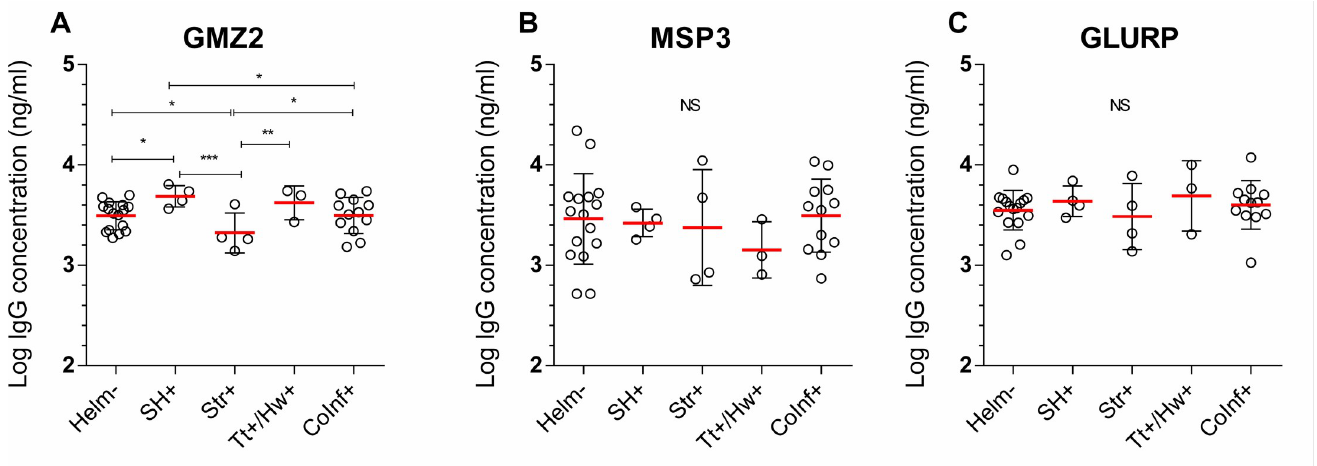
Fig 3. Post immunization antibody concentration at D84 in Helm- and Helm+ subgroups. Fig 3 illustrates the log of specific-GMZ2 (A), specific-MSP3 (B), specific GLURP (C) IgG concentration at D84 in Helm- and mono-infected by Schistosoma haematobium (Sh+, n = 4), those mono-infected with Strongyloides (Str +, n = 4), those mono-infected with Trichuris trichiura or hookworm (Tt+/Hw+, n = 3), and those coinfected by at least two different helminths (Coinf+, n = 12). The comparison was performed by multivariate linear regression adjusted for baseline vaccine-specific total IgG concentration as independent covariable. The graphs show mean ± standard deviation. Statistical significance was set for p value below 0.05 and is indicated when statistically significant. � p < 0.05, �� p < 0.01, ��� p < 0.001. NS = Non-significant.